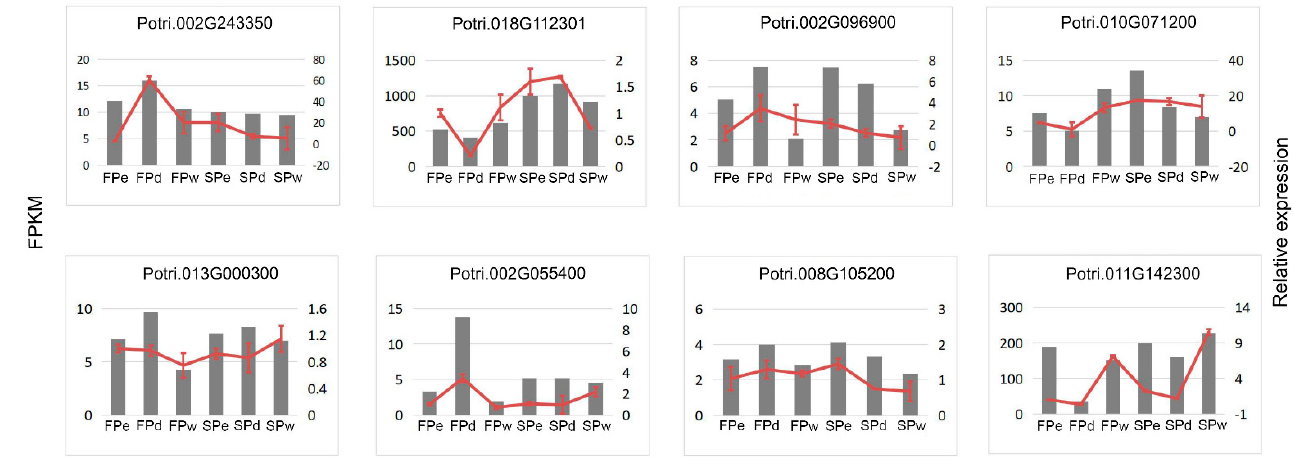
Figure 6. The expression of eight key genes was confirmed by quantitative Real-Time PCR (qRT-PCR). The FPKM values of eight genes obtained by RNA-Sequencing are shown as grey columns, and relative expression levels of target genes by qRT-PCR are shown as red lines with standard error. Three biological replicates and three technical replicates were conducted for each sample.